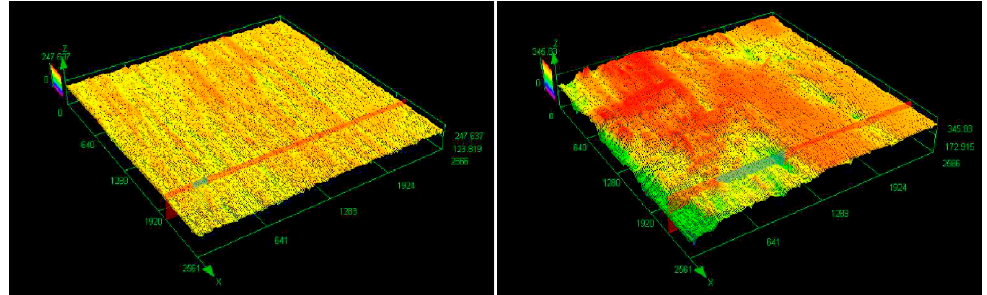
Figure 4. 3D image of poplar wood surface before ( left ) and after 2 years of weathering ( right )—confocal laser scanning microscopy (area of 800 × 800 μ m).